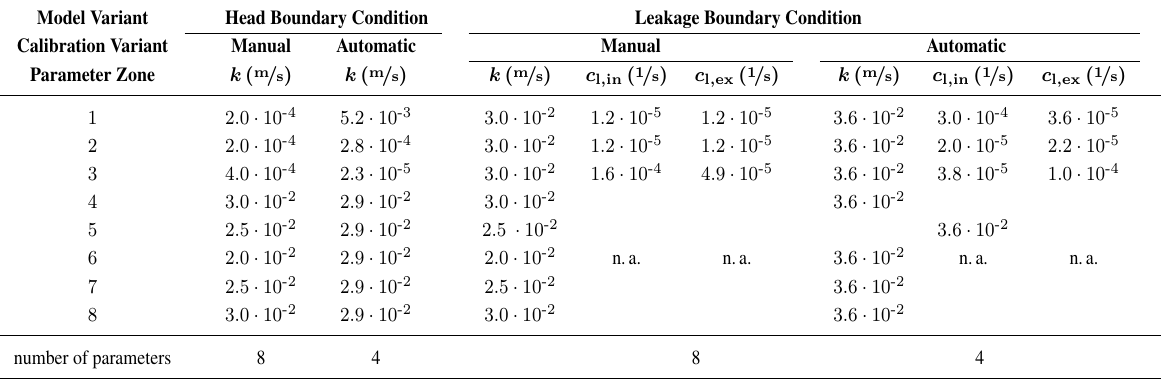
Figure 10. Detail of the 3D groundwater model “Urmitz”, where the river is modeled with a leakage boundary condition with calibration results for the leakage parameters c coloring of the finite elements indicates the values of leakage parameters obtained by manual and automatic calibration (see Section 4.5 and Table 3). ( a ) Results of manual calibration; ( b ) results of automatic calibration. Table 3. Assignment of parameter zones for the model/calibration variants and calibration